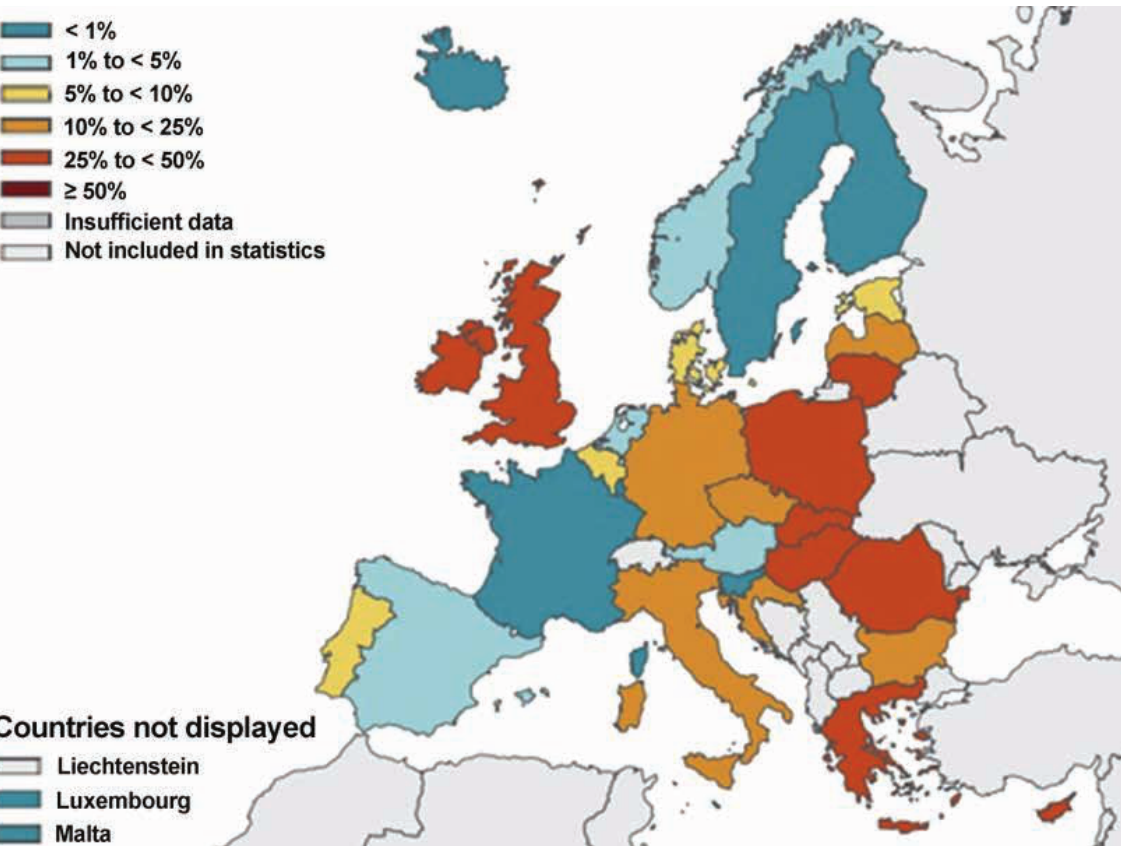
Figure 5 : Map of Europe with a percentage of resistant strains from total number of isolates in species E. faecium in year 2017